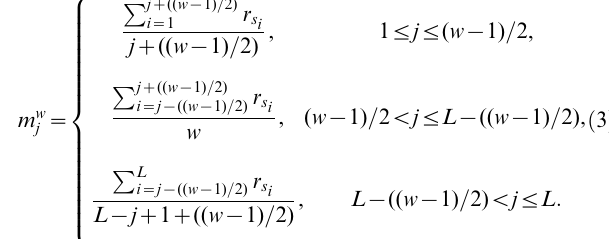
Table 1. Illustration of the calculation of the averaged compositional index values m w